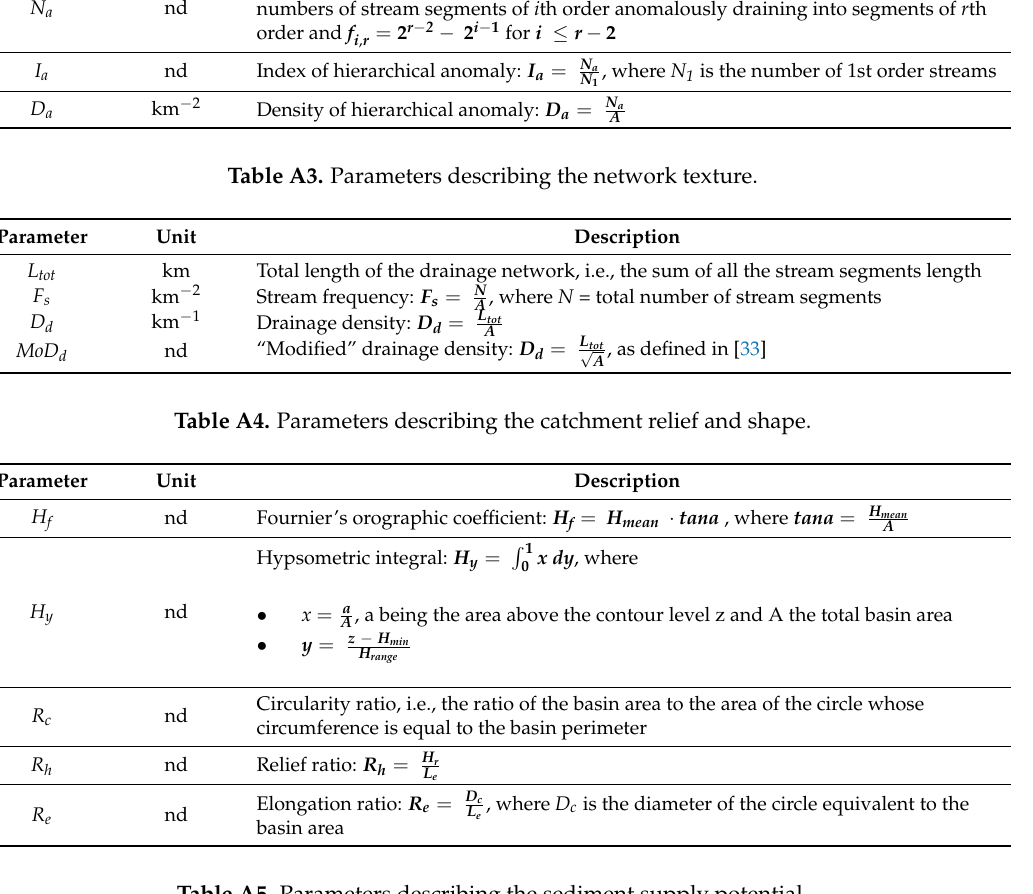
Table A5. Parameters describing the sediment supply